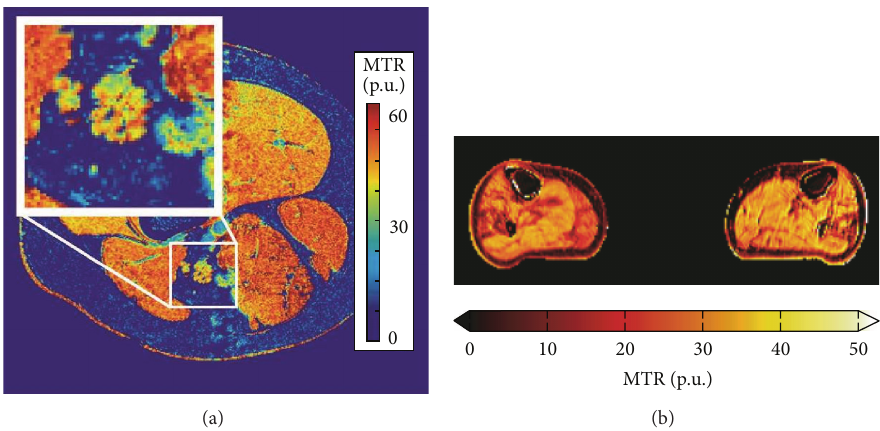
Figure 11: (a) MT neurography imaging of the sciatic nerve- Magnetization transfer ratio map at the mid-thigh level. Inset: enlargement of the sciatic nerve demonstrates measurable MTR effect in the nerve. (b) MT muscle imaging of neuropathy. Magnetization transfer ratio map of the mid-calf muscles of a patient with Charcot-Marie-Tooth disease type 1A (CMT1A). The MTR is reduced in areas affected by pathology. The maps have been corrected for RF inhomogeneities with a compensation method using B1 transmit maps